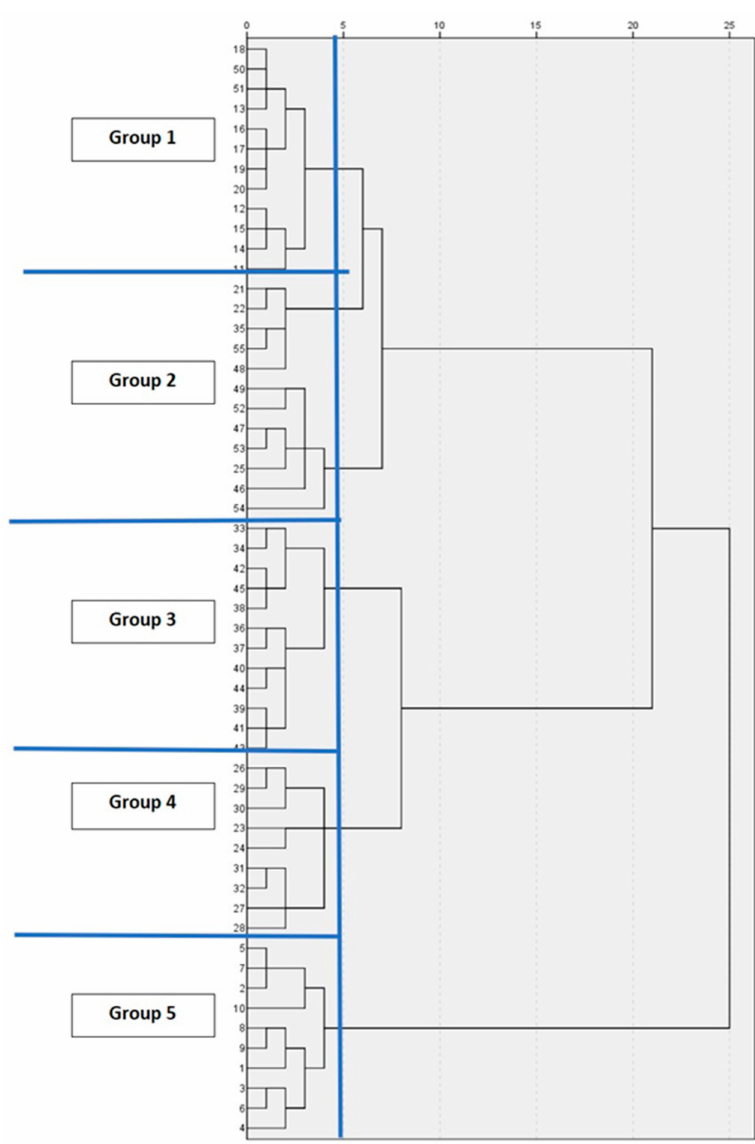
Figure 2. Dendrogram for clustering and identification of groups of small pig farms in